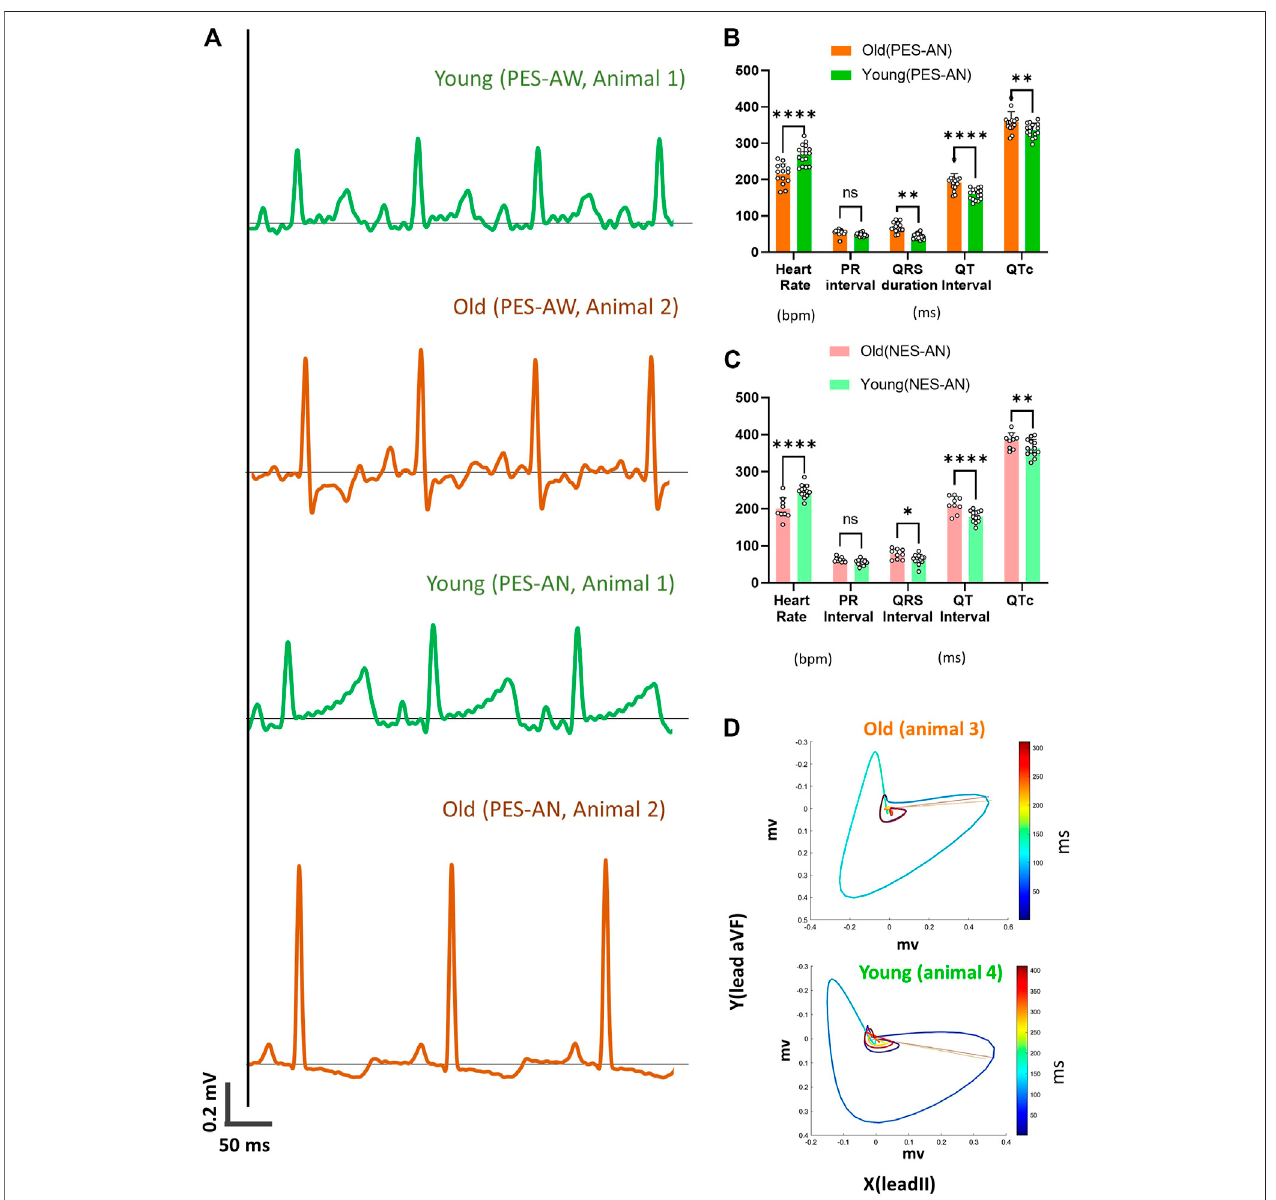
FIGURE 5 | Age-dependent effects on ECG parameters. (A) . Example lead I ECG traces acquired from a young female and old female guinea pig using a platform ECG system. (B) . Comparison of different ECG metrics from old ( n = 14) and young ( n = 16) animals using PES-AN. (C) . Comparison of different ECG metrics from old ( n = 9) and young ( n =13) animals using NES-AN. 2-way ANOVA with 0.05 FDR cutoff was used to calculatethe p values. (D) . Frontal plane VCG in ayounger and older adult animal. p p < 0.05, pp p < 0.01, ppp p < 0.001, pppp p < 0.0001.